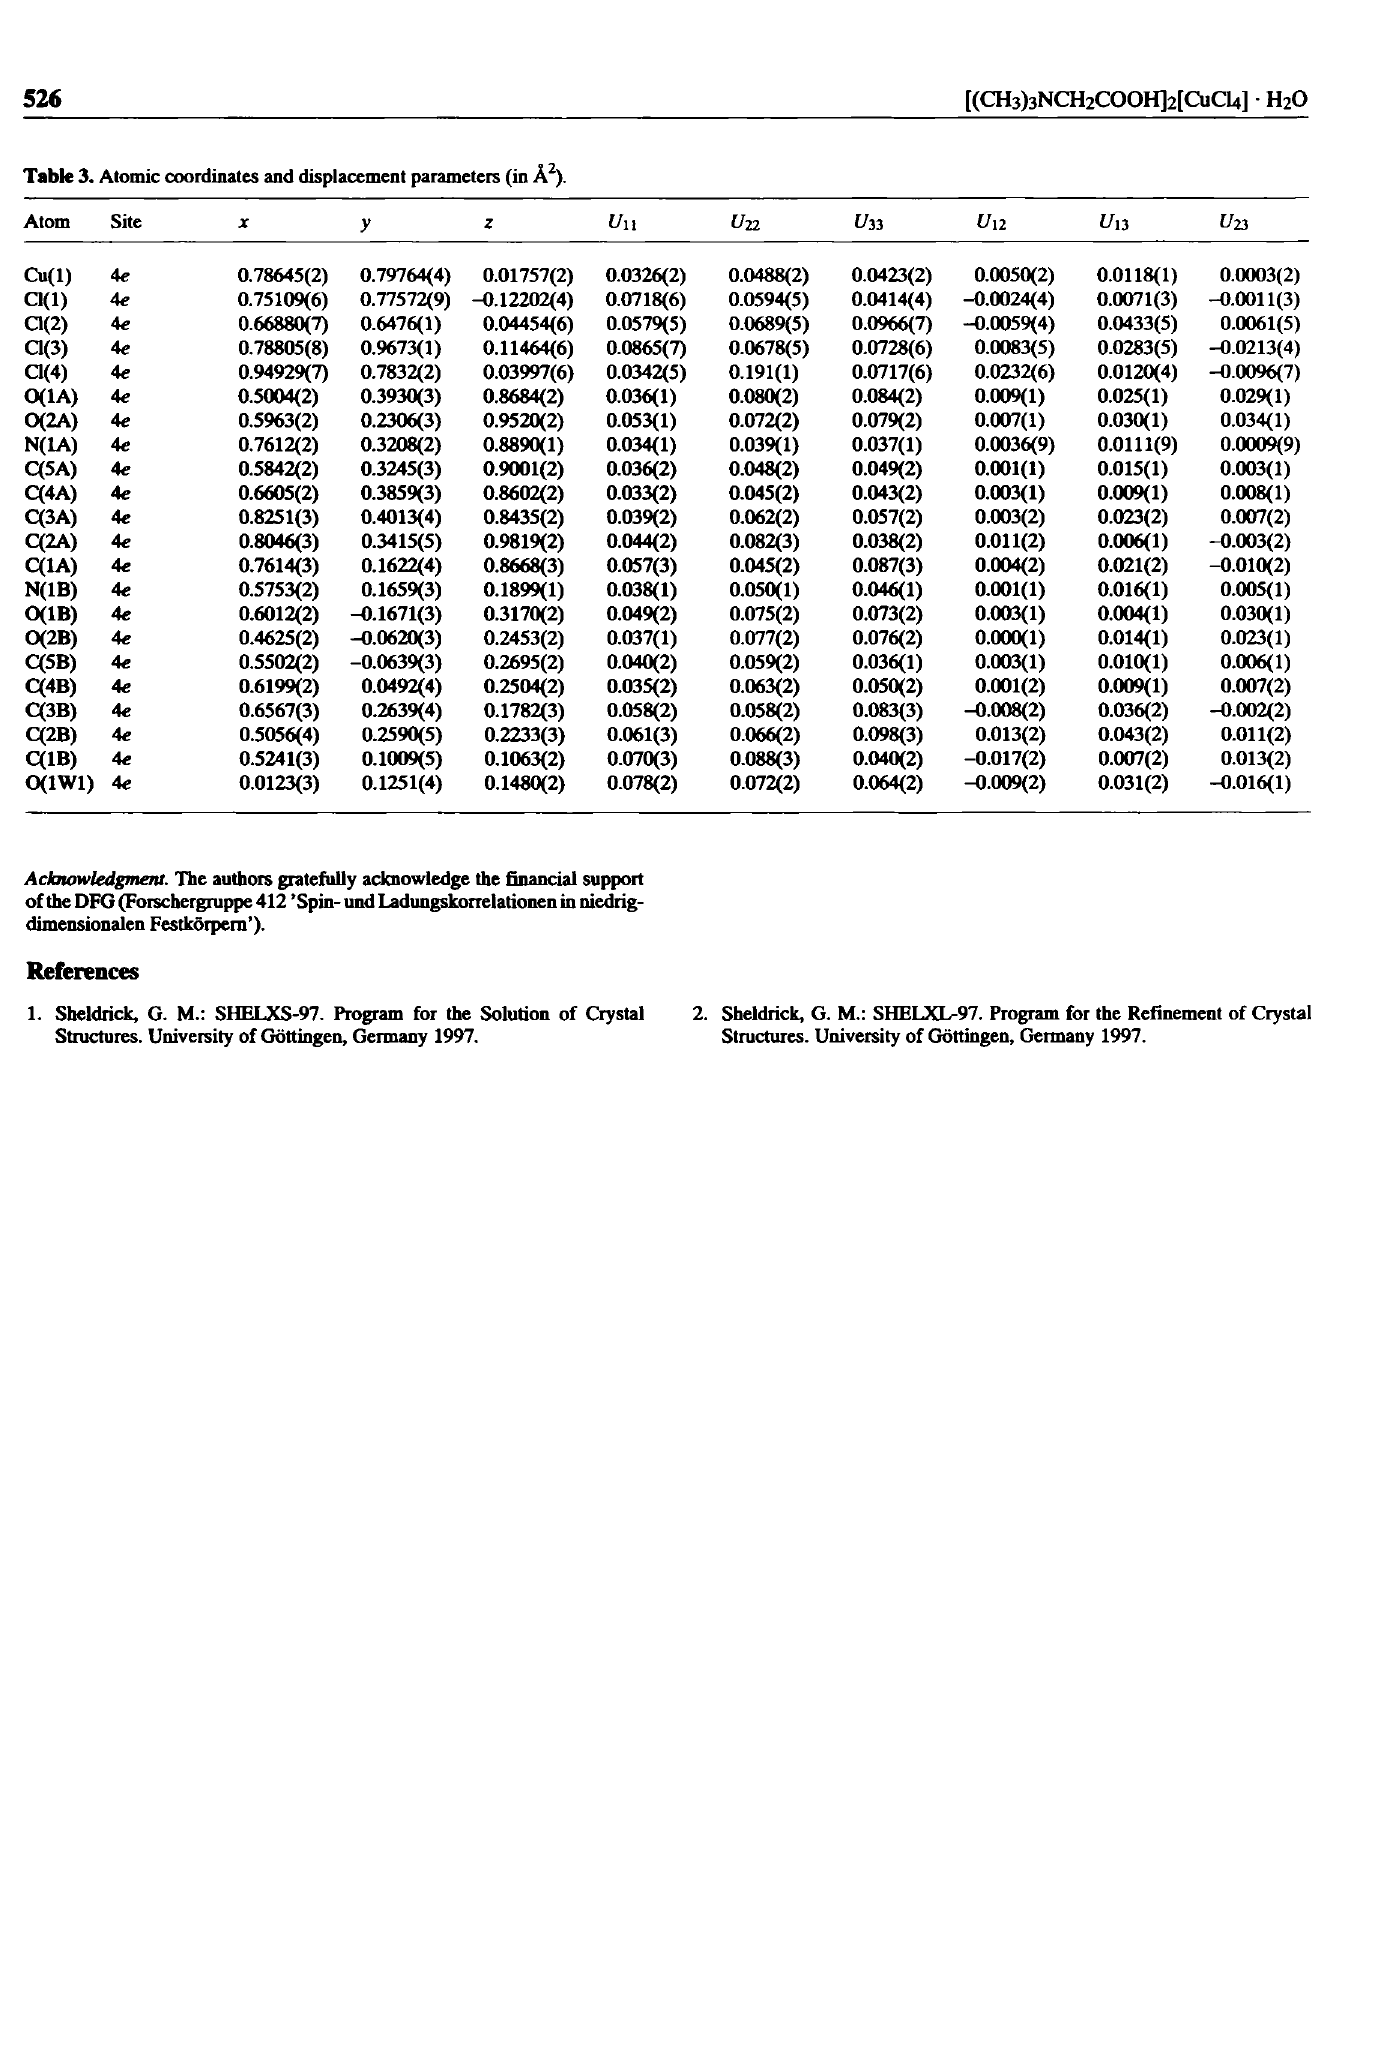
Table 3. Atomic coordinates and displacement parameters (in Ä 2